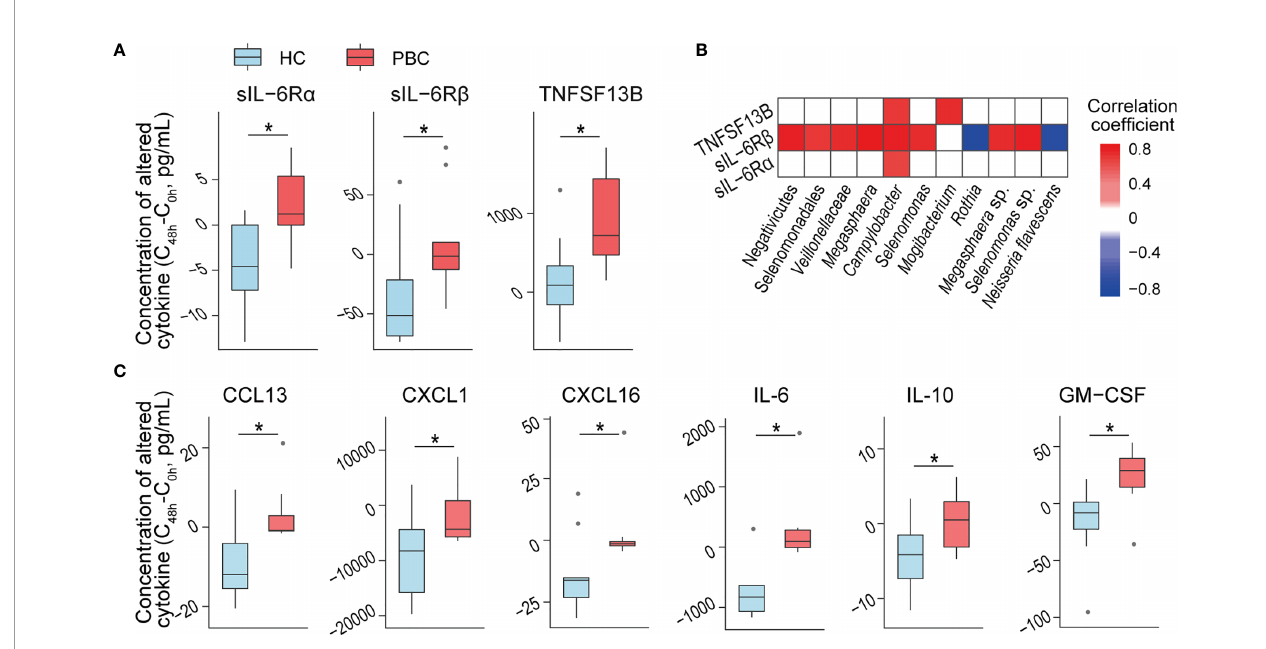
FIGURE 4 | PBC salivary microbes and supernatants induce more in fl ammatory cytokine secretion than HC salivary microbes from keratinocytes and THP-1 macrophages. (A) In fl ammatory cytokine concentrations that were differentially expressed in OKF6 cells after coculture with HC or PBC salivary microbes. (B) Association of the relative abundance of salivary microbes with altered cytokine concentrations after the coculture of OKF6 with HC or PBC salivary microbes. (C) In fl ammatory cytokine concentrations that were differentially expressed in THP-1 macrophages after coculture with HC or PBC salivary supernatants. * P <